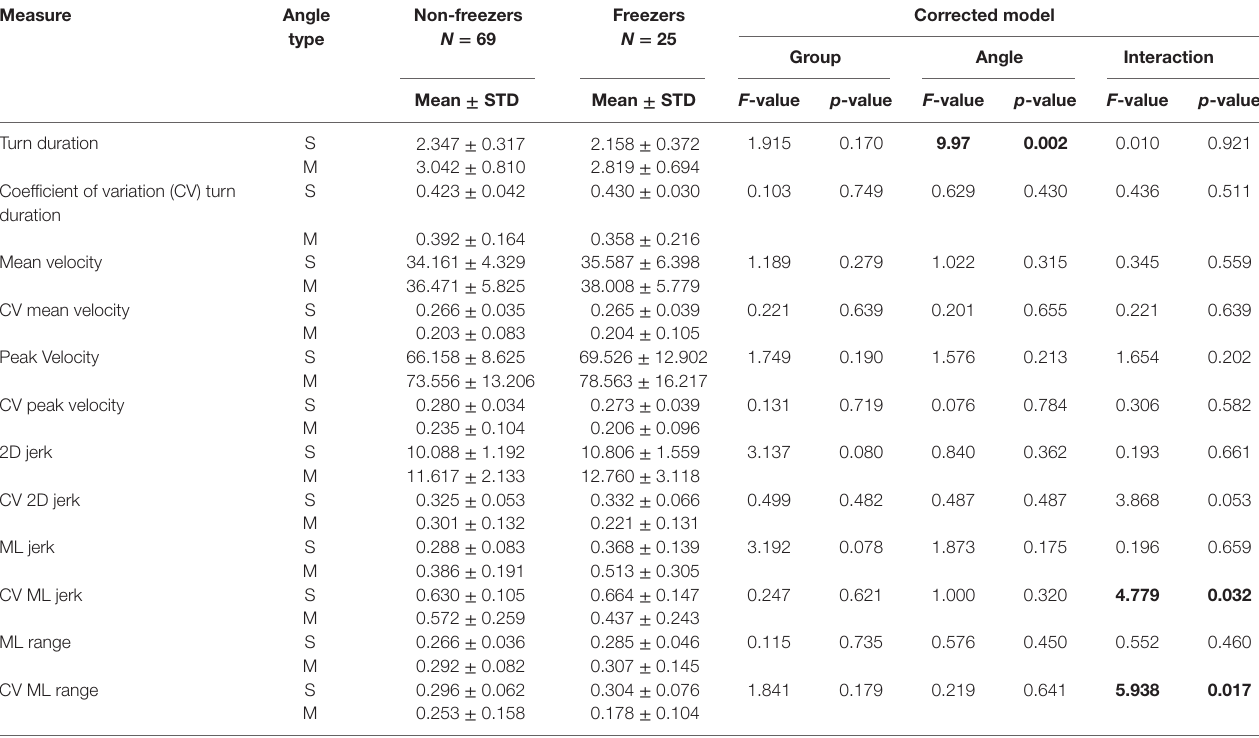
TaBle 3 | Three-day measures of quality of turning divided by angle amplitude in non-freezers and